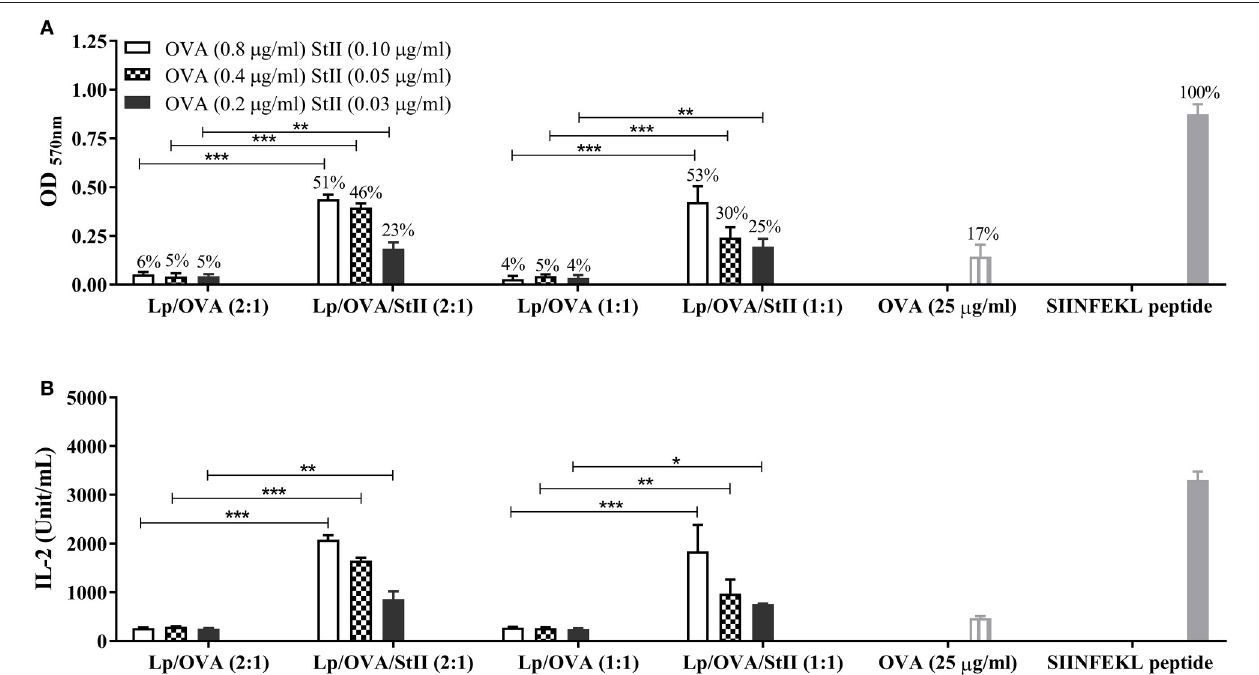
FIGURE 2 | StII co-encapsulated with OVA into liposomes with two different ratios of cholesterol induced antigen cross-presentation in BM-M 8 s. Bone marrow-derived macrophages (BM-M 8 s) from C57BL/6 mice were cultured for 90min with the indicated concentration of OVA co-encapsulated or not with StII into liposomes containing different ratios of DPPC and Chol, [Lp/OVA/StII (2:1), Lp/OVA (2:1), Lp/OVA/StII (1:1), Lp/OVA (1:1)]. BM-M Φ s stimulated with 25 µ g/ml soluble OVA and 10nM SIINFEKL peptide were used as experimental controls. After stimulation, cells were washed and co-cultured with OVA-specific B3Z CD8 + T cells. β -galactosidase activity of the B3Z cells was assessed by a colorimetric assay. (A) Mean ± SEM of OD 570nm of three independent experiments are shown. Efficiency of antigen cross-presentation with respect to the SIINFEKL peptide is also shown above each bar. (B) IL-2 concentration in culture supernatants was measured by ELISA. Means ± SEM of two independent experiments are shown. Statistical analysis was performed with the Mann-Whitney U-test: * p < 0.05, ** p < 0.01, *** p < 0.001.